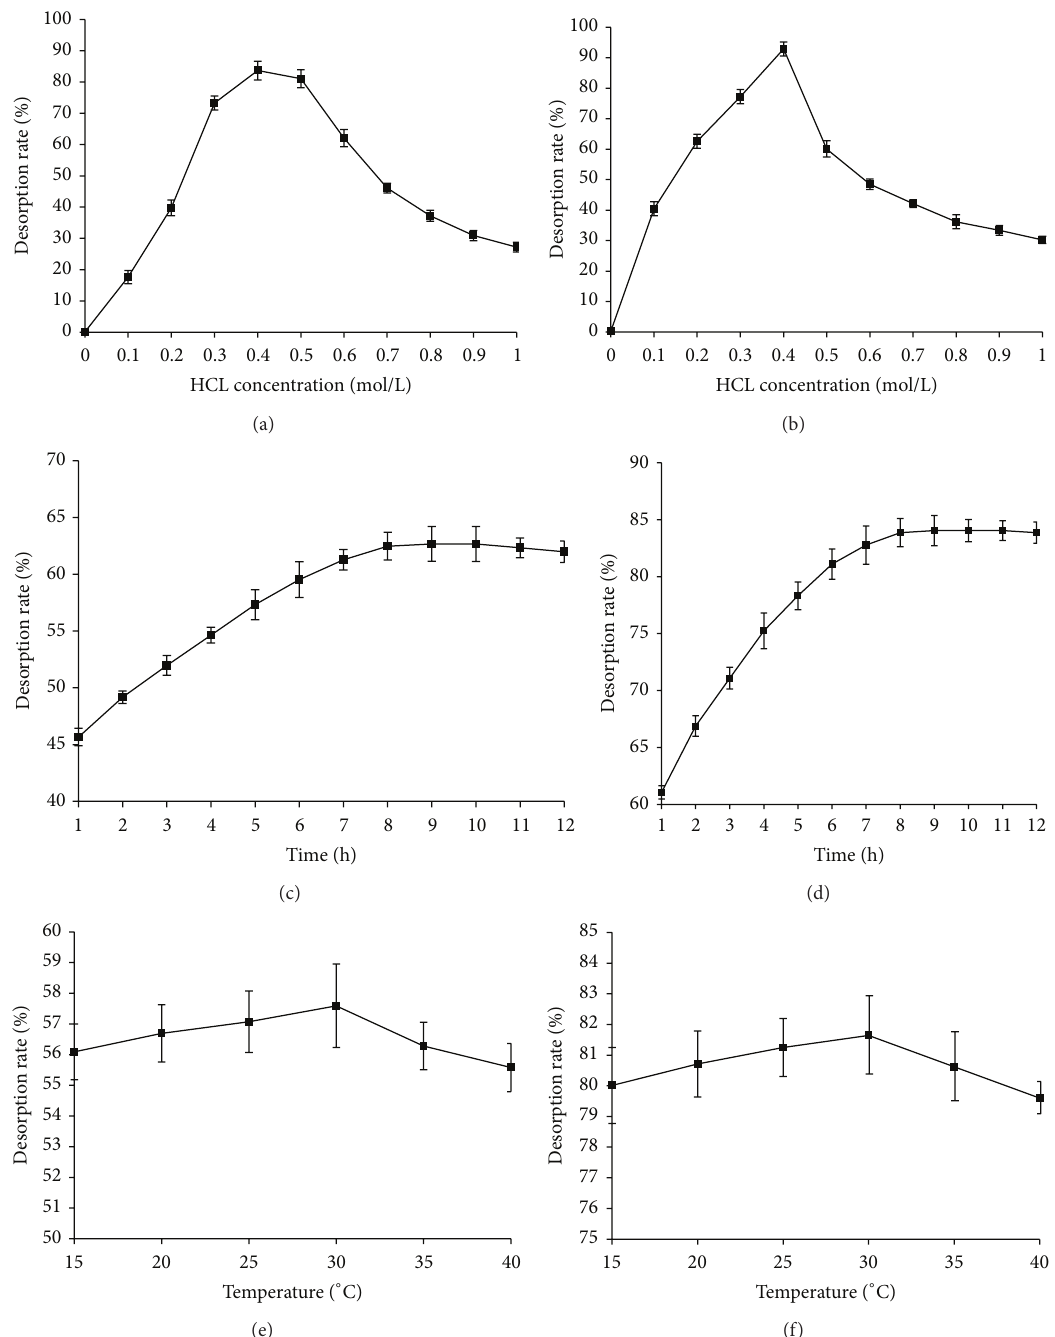
Figure 5: Effects of desorption factors on the 𝜀 -PL desorption efficiencies of HZD-3B and D155 resins. (a) HCl concentration for HZD- 3B resin; (b) HCl concentration for D155 resin; (c) desorption time for HZD-3B resin; (d) desorption time for D155 resin; (e) desorption temperature for HZD-3B resin; (f) desorption temperature for D155